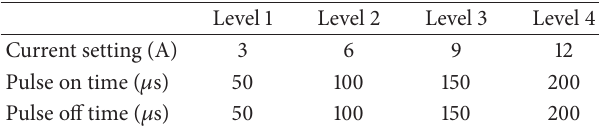
Table 1: Parameters and their